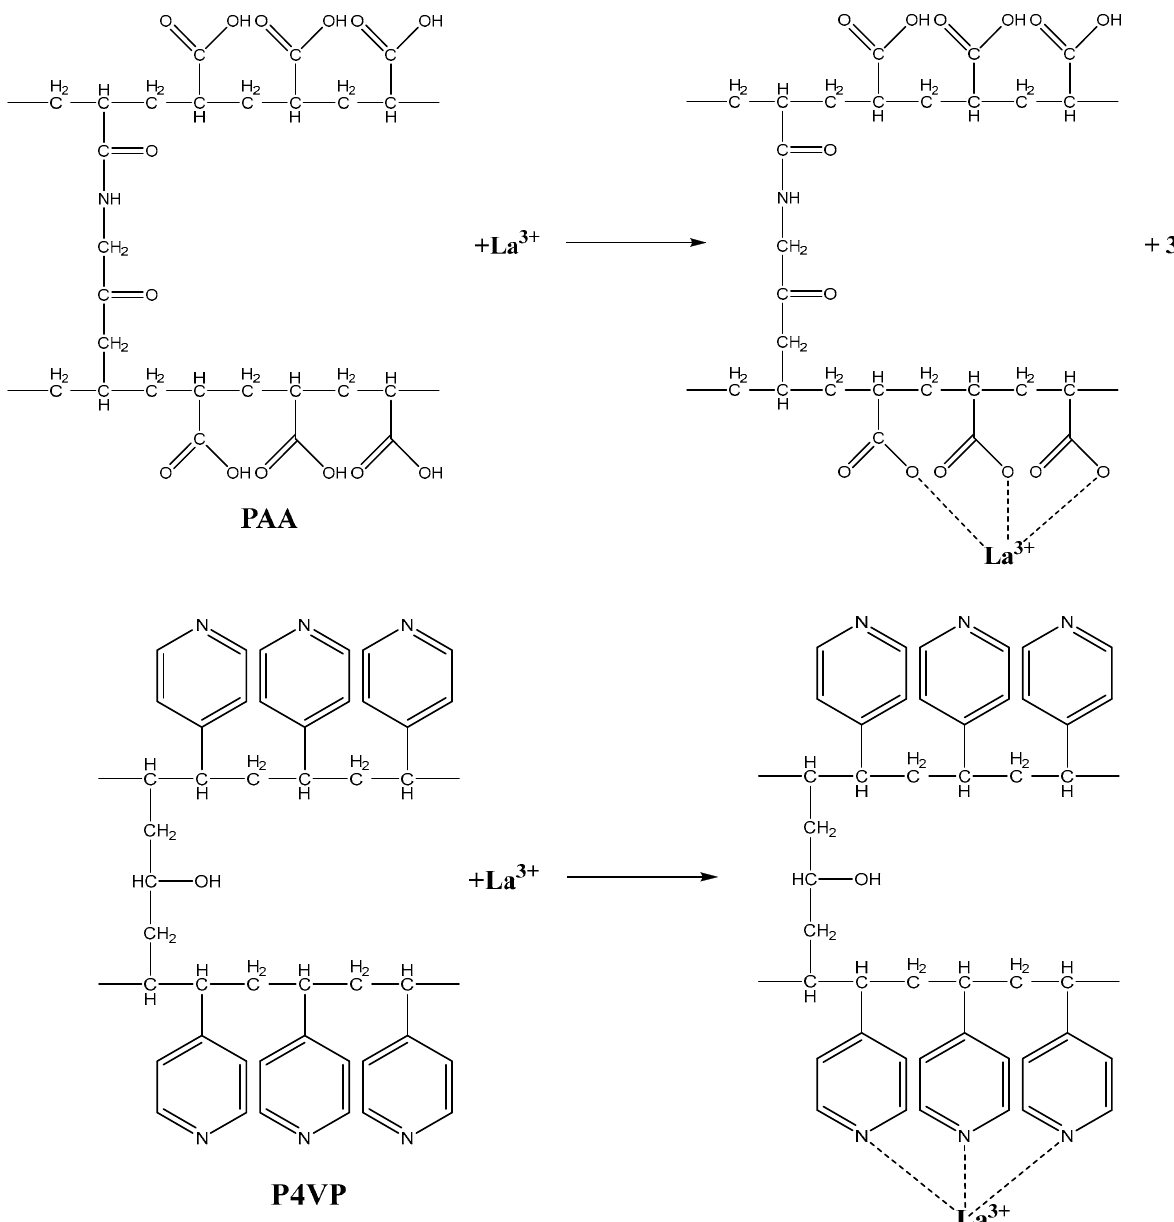
Figure 5. Proposed mechanism of lanthanum sorption for PAA and P4VP hydrogels. The values of the lanthanum sorption degrees of the studied interpolymer systems are presented in Table